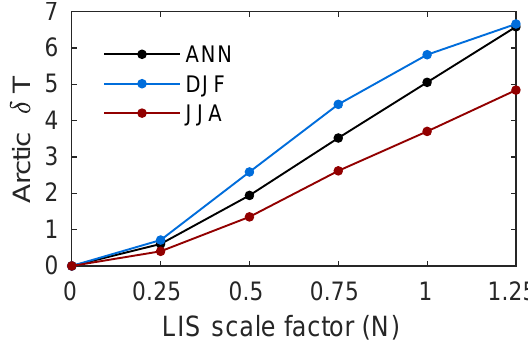
Figure 2. The Arctic surface temperature anomaly ( ◦ C) (area- weighted average between 70 and 90 ◦ N) with respect to LIStopo0 for the annual mean (ANN), boreal winter (DJF), and boreal sum- mer (JJA)